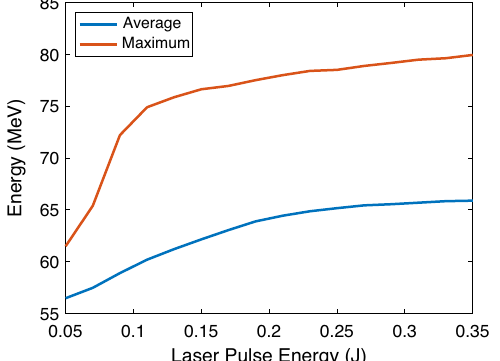
FIG. 4. Normalized maximum and average output energy for the Rubicon undulator tapering tune used in the recirculated IFEL experiment as a function of input laser pulse energy.